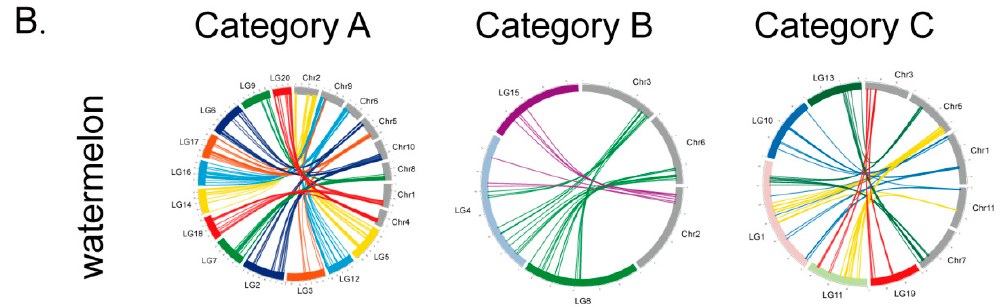
Figure 4. Alignment result with watermelon genome and the pairwise relationship around linkage groups. ( A ) Dot plots represent the alignment results between C. pepo and the watermelon genomes. The horizontal axis shows the genetic position of 20 C. pepo LGs, while the vertical axis shows the physical position of the 11 watermelon chromosomes. Each dot corresponds to a single marker and represents one tBLASTx hit between C. pepo LGs and watermelon chromosomes; ( B ) circos plots that reveal the presence of three categories on the basis of syntenic relationships between C. pepo and watermelon. The LGs in this figure are shown with colored bars while the chromosomes of watermelon are shown with grey bars. The outside scale bars refer to cM in the case of LGs and Mb in the case of chromosomes, respectively. Category A includes twelve LGs (LG20 and LG18, LG5 and LG14, LG16 and LG12, LG17 and LG3, LG2 and LG6, and LG7 and LG9) that show roughly two-to-one relationships with chromosomes of watermelon, melon, and cucumber. Category B includes three LGs (LG4, LG8, and LG15). The front region of LG4 corresponds with LG8 while the backend region of LG4 corresponds to LG15. No syntenic region is shared between LG8 and LG15 in the three genomes. Category C includes five LGs (LG1, LG10, LG11, LG13, and LG19). The backend region of LG11 corresponds to LG19 while the front region of LG11 corresponds to the middle region of LG1. The front region of LG1 corresponds to LG10 and the backend region of LG1 corresponds to LG13.